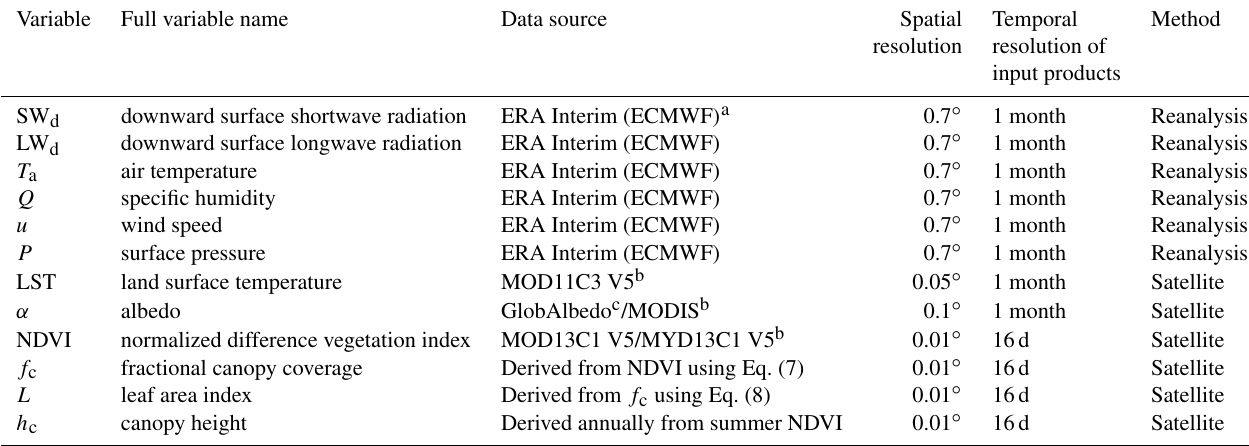
Table 1. Input datasets used to calculate the surface energy fluxes over the Iberian Peninsula from 2000 to 2018.